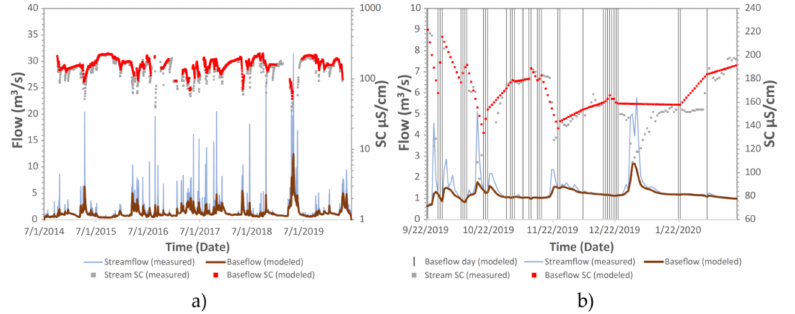
Figure 4. ( a ) Calibrated model outputs of streamflow, baseflow, stream SC, and baseflow SC for the two-pass (2p) scenario at Falls River, Michigan. ( b ) Close-up results showing the pattern of modeled baseflow and baseflow SC, which depends on the timing and stream SC value on consecutive baseflow days (vertical lines) determined through the optimization. Note the underprediction of modeled baseflow SC (i.e., SC b < SC y ) on several occasions (e.g., February 2020), which increases the error in objective function